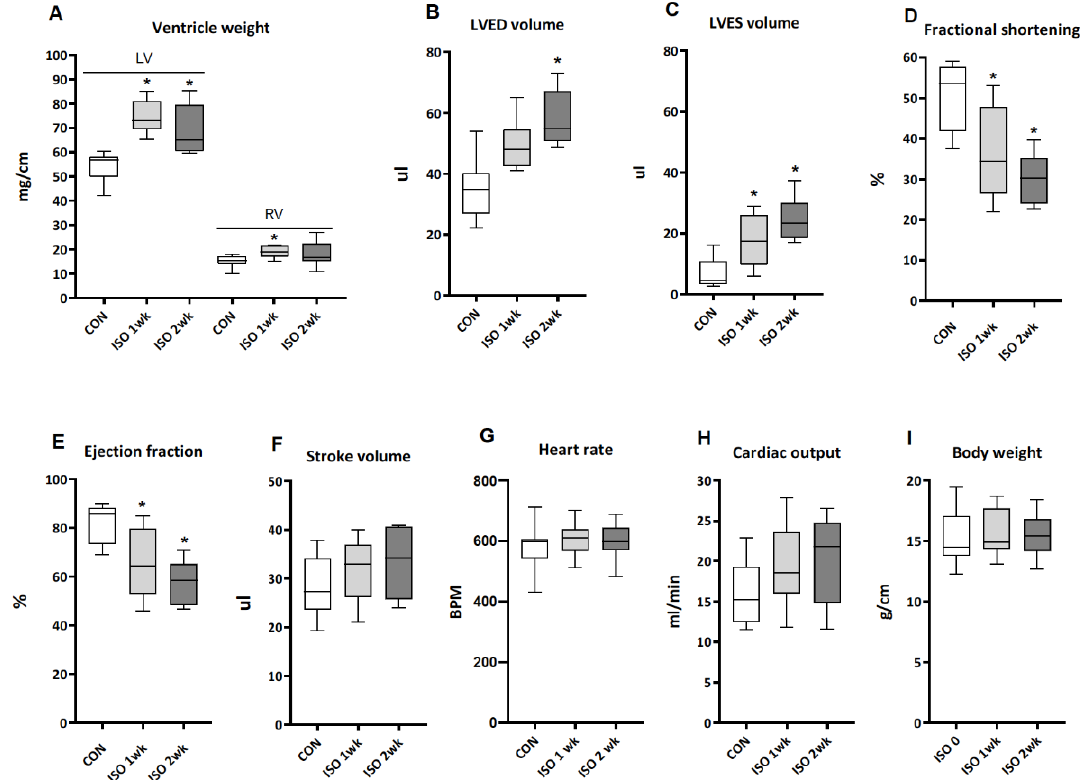
Figure 1. The effect of one and two weeks of ISO infusion on cardiac parameters and body weight. ( A ) Ventricle weight was normalized to tibia length. Data in panels ( B – H ) were obtained by echo- cardiography. ( B ) LVED: left ventricular end-diastolic; ( C ) LVES: left ventricular end-systolic. Data are presented as median and quartiles with whiskers indicating minimum and maximum values.